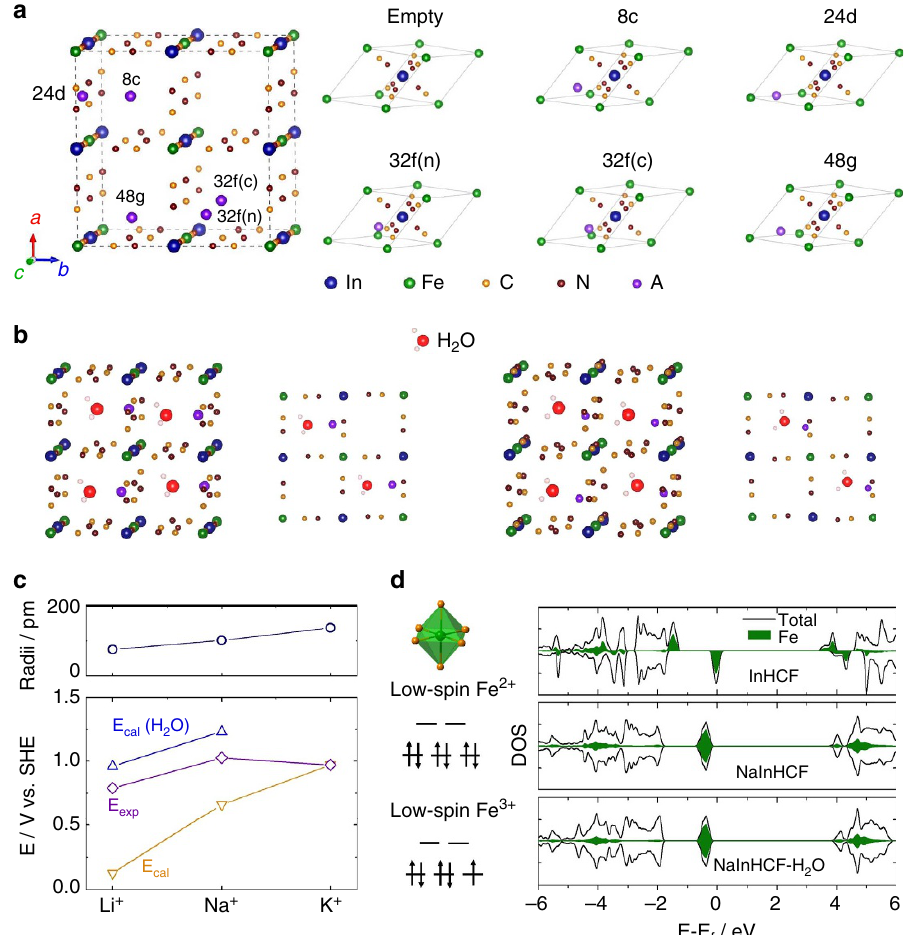
Figure 6 | DFTcalculations. ( a ) Crystal structure of InHCF with five possible interstitial sites and primitive cells of InHCF with A þ occupying the empty, 8c (body centre), 24d (face centre), 32f(n) (displaced from 8c sites toward N-coordinated corner), 32f(c) (displaced from 8c sites toward C-coordinated corner) and 48g (displaced between 8c and 24d) sites. ( b ) Crystal structures of InHCF with intercalation of [Na-OH 2 ] þ (left of panel) and [Li-OH 2 ] þ (right of panel). ( c ) Comparison of ionic radii and intercalation voltage for Li þ , Na þ and K þ . ( d ) Schematics of the electronic states of Fe at different oxidation states and spin states, and electronic density of states projected on Fe ions in InHCF, NaInHCF and NaInHCF-H 2 O.